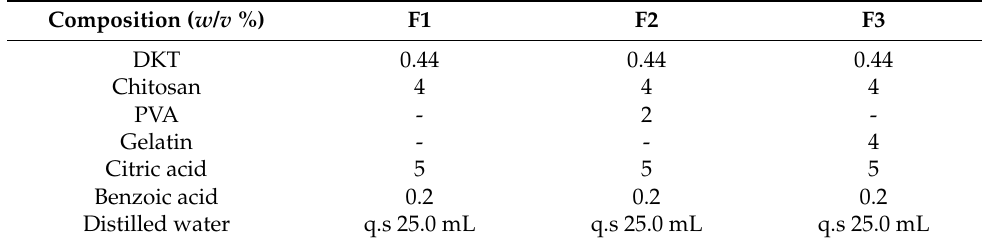
Table 1. Scaffolds prototypes for DKT controlled release. Composition ( w / v %) F1 F2 F3 DKT